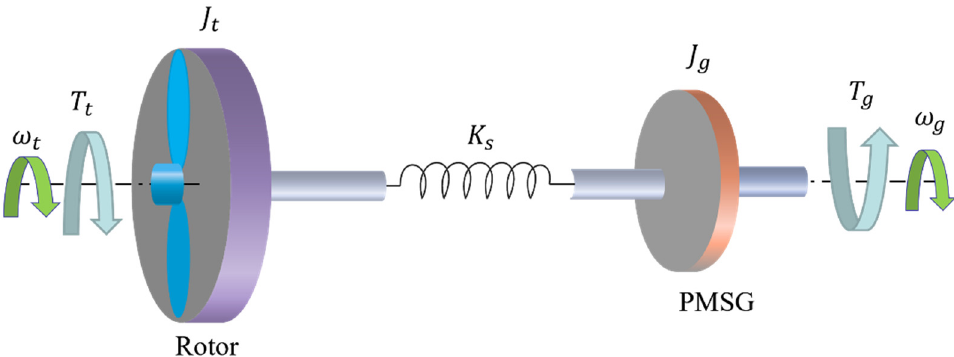
Figure 2. Two-mass drive-train model. In this model, J t is the moment inertia of rotor; J g is the moment inertia of generator; ω t is the rotor speed of wind turbines; ω g is the mechanical speed of the generator rotor; T t is the mechanical torque of wind turbines; T g is the electromagnetic torque of the generator system; K s represents the equivalent stiffness of the two-mass model.